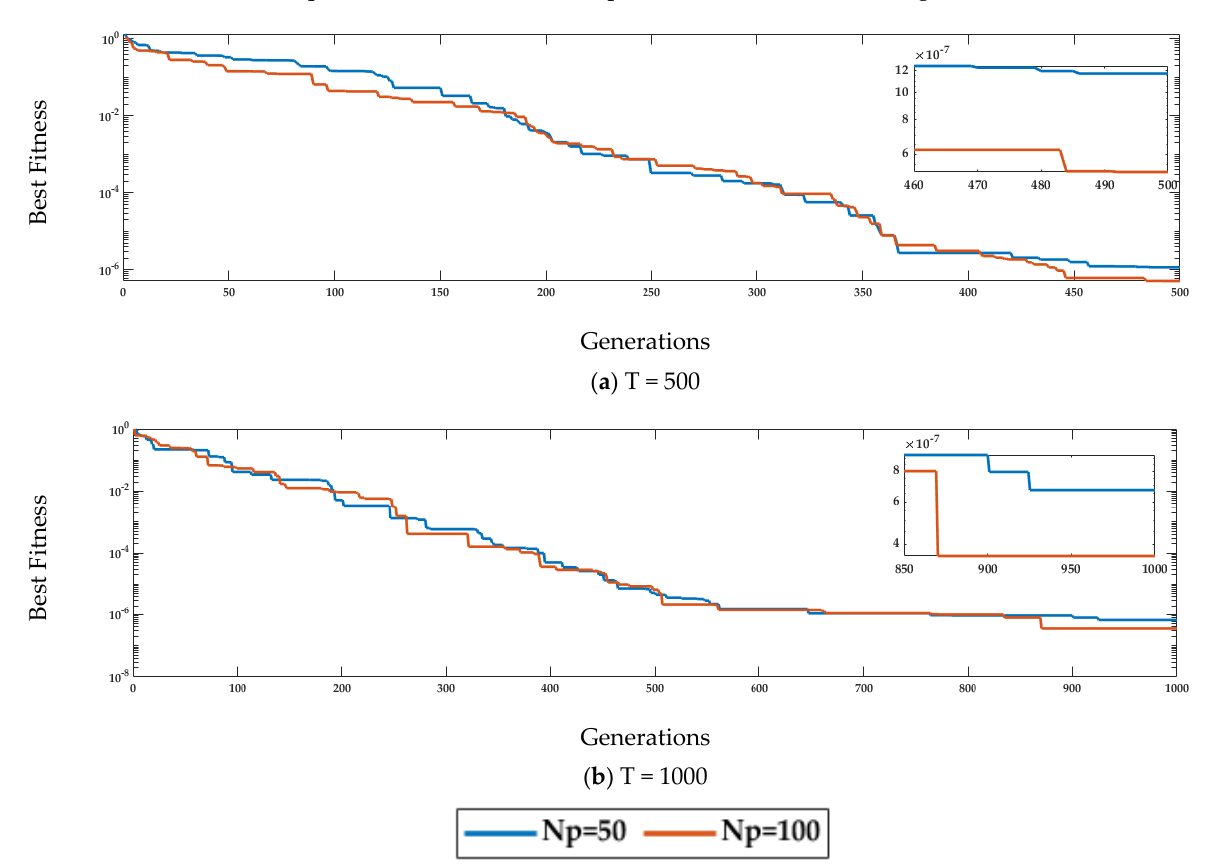
Figure 2. Fitness plots for MPA w.r.t population sizes for case study 1. The fitness curves in Figure 2a correspond to the best fitness of the MPA algorithm for generation T = 500, while Figure 2b correspond to same variation for generation T = 1000. It is noted from Figure 2a,b that the fitness of MPA for the two generation variations, i.e., [500, 1000], reduces with the increase in population sizes. The performance of MPA is also evaluated in terms of the generation variations as demonstrated by the fitness curves in Figure 3.